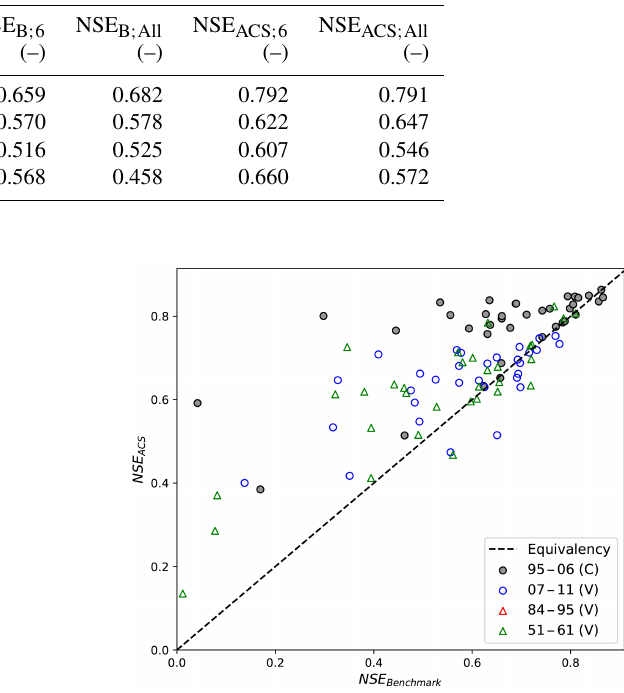
Figure 17. Nash–Sutcliffe efficiency of the ACS-based model and benchmark model; free parameterization.